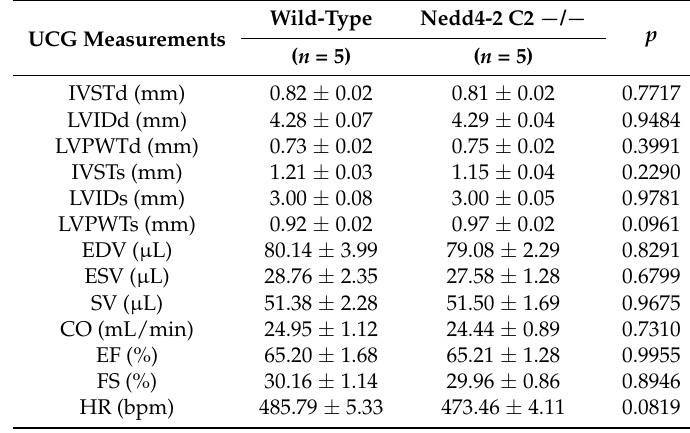
Table 2. Comparison of echocardiographic (UCG) findings between wild-type and Nedd4-2 C2-knockout mice. Male wild-type littermates ( n = 5; 8–9 weeks old) and Nedd4-2 C2 − / − mice ( n = 5; 8 weeks old) were used in this experiment. Data are expressed as means ± SE. Echocardiographic parameters showed no difference between wild-type and Nedd4-2 C2-knockout mice. IVSTd, intraventricular septal thickness in diastole; LVIDd, left ventricle internal diameter in diastole; LVPWTd, left ventricular posterior wall thickness in diastole; IVSTs, intraventricular septal thickness in systole; LVIDs, left ventricle internal diameter in systole; LVPWTs, left ventricular posterior wall thickness in systole; EDV, end diastolic volume; ESV, end systolic volume; SV, stroke volume; CO, cardiac output; EF, ejection fraction; FS, fractional shortening; HR, heart rate. UCG Measurements